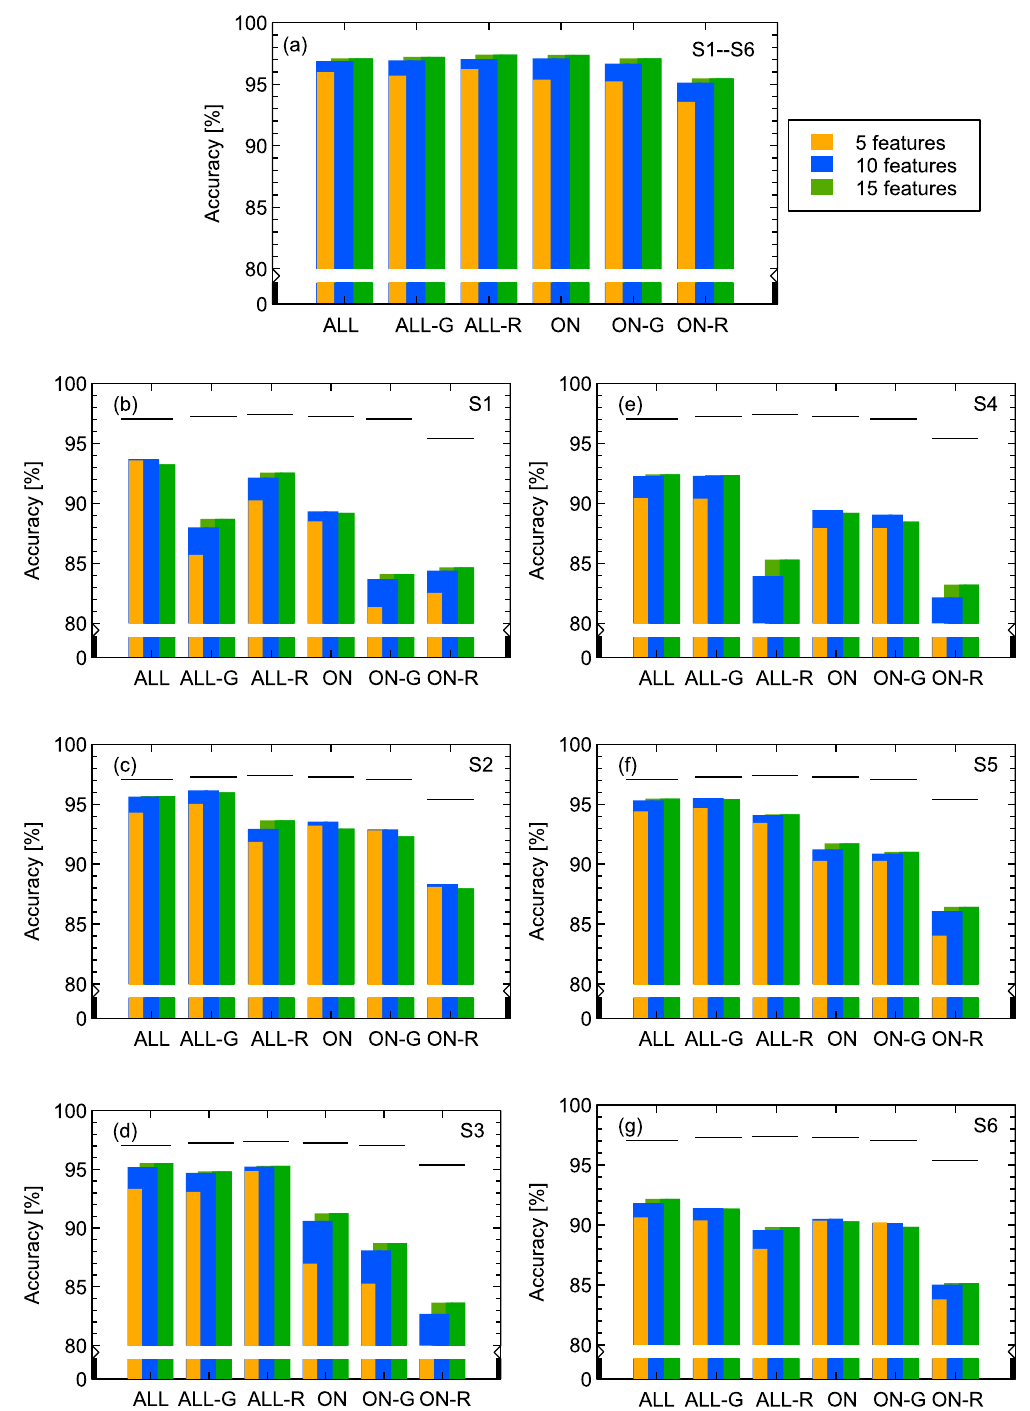
Figure 7. Accuracy of models trained on various subsets of features available for the recursive forward selection method: ALL—all prepared types of features, ALL-G—only features extracted from the conductance, ALL-R—only features extracted from the resistance, and ON, ON-G, ON-R—only features extracted from the gas adsorption part of the response. ( a ) Data from all sensors are used, ( b – g ) data from individual sensors are used for model training; sensors are indicated in sub-figures. Individual bars from left to right in each group display values obtained for 5, 10, and 15 features, respectively. Ticks above bars in figures ( b – g ) indicate the level of model accuracy obtained with all sensor data, as presented in figure ( a ). Charts ( b – g ) are ordered such that data from the same type of sensor are presented by